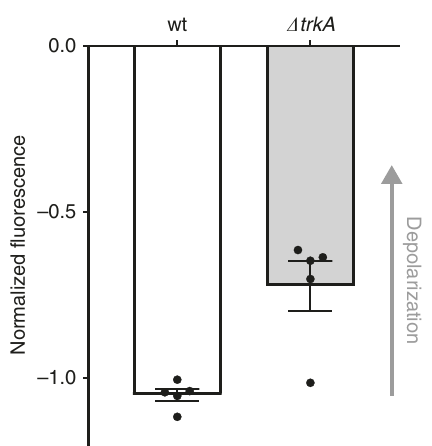
Fig. 7 Deletion of TrkA leads to membrane potential depolarization in E. coli . The relative membrane potentials of wild-type (wt) and Δ trkA E. coli strains as determined by a fl uorescence-based assay. The Δ trkA cells are depolarized relative to wt cells ( n = 5, p < 0.001). Points representing each measurement are overlaid with the bar graph. Error bars are s.e.m. The chart was prepared using GraphPad Prism.